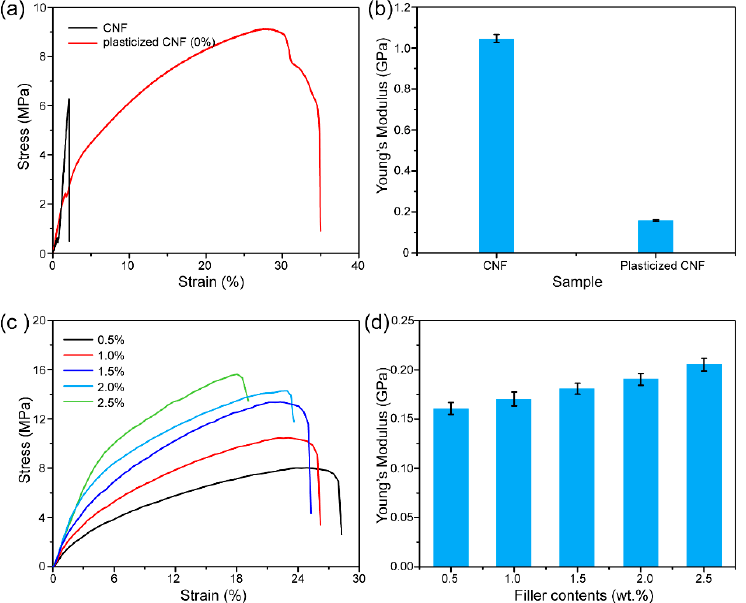
Figure 3. Mechanical properties of CNF/AgNW conductive paper: ( a ) The strain–stress curve for the CNF paper and plasticized CNF paper; ( b ) Young’s modulus of CNF paper and plasticized CNF paper; ( c ) the strain–stress curve for the plasticized CNF/AgNW paper; ( d ) Young’s modulus of plasticized CNF/AgNW paper.